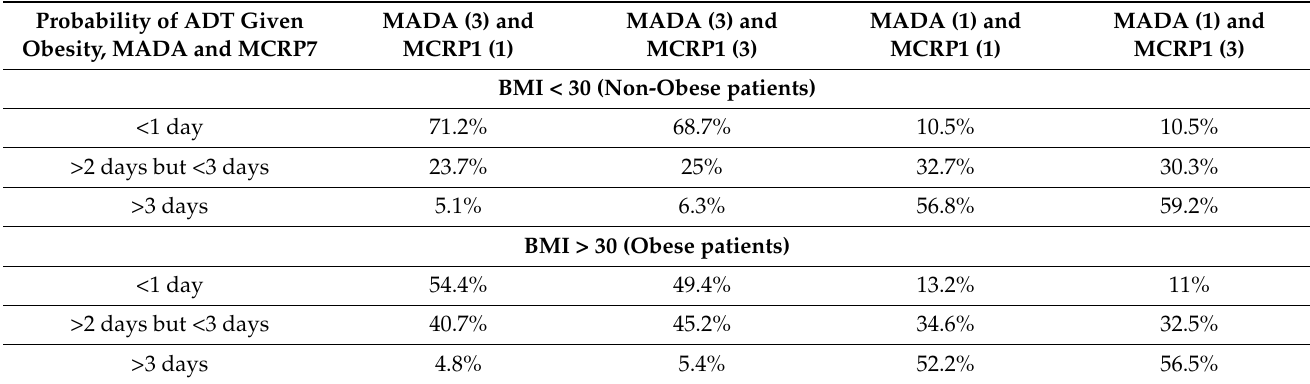
Table 7. The heat-mapped, conditional probabilities of ADT given different configurations of Obesity, MADA and MCRPI. Probability of ADT Given Obesity, MADA and MCRP7